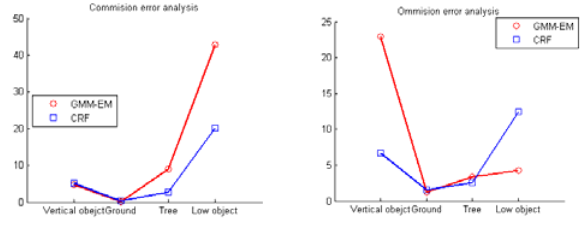
Tabel 1. Cross-validation results obtained from GMM-EM and CRF classification.